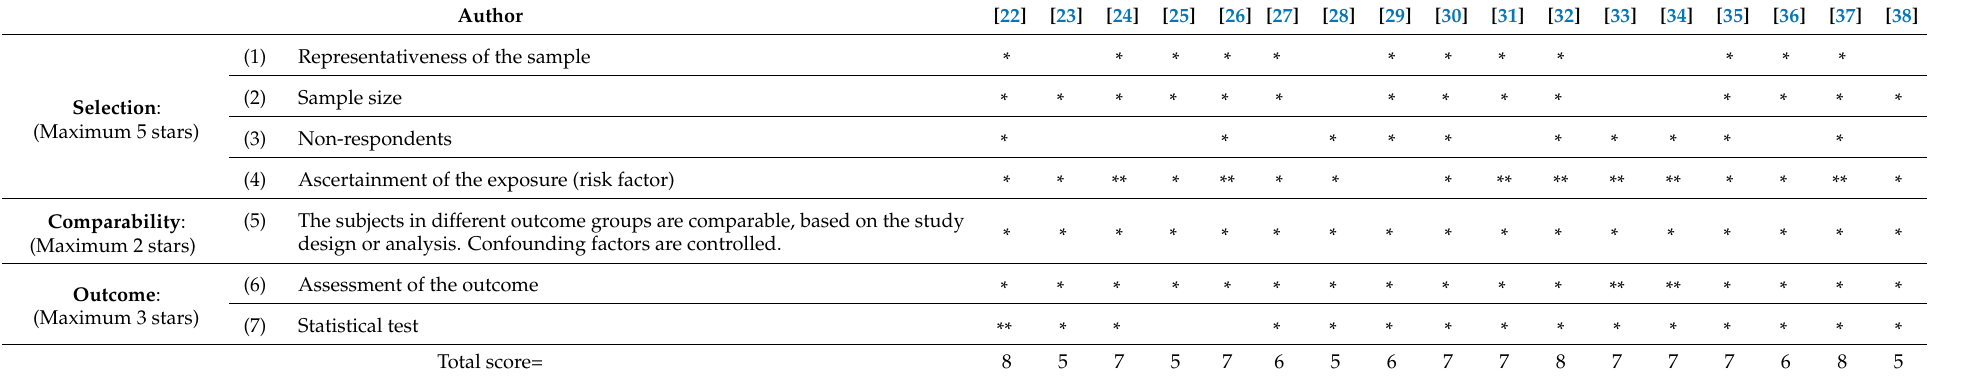
Table 1. Newcastle–Ottawa Scale adapted for cross-sectional studies.